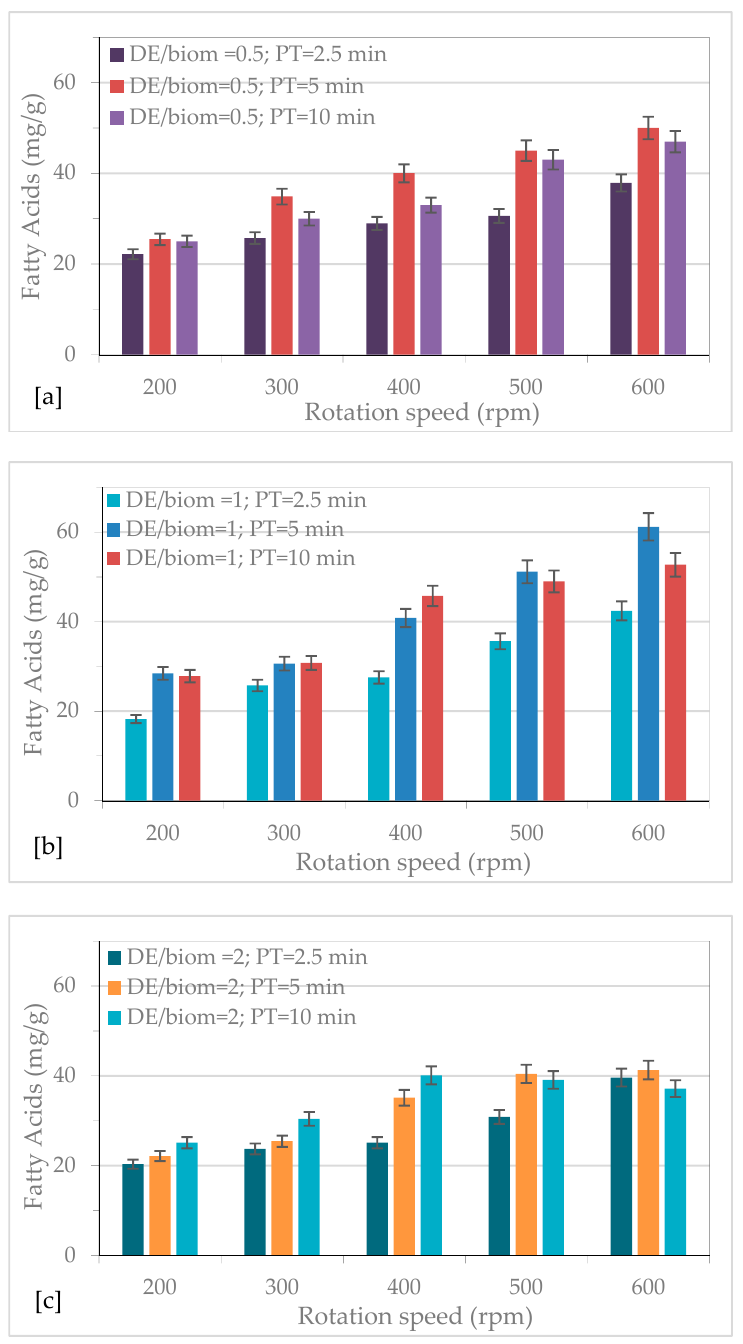
Figure 1. Effect of rotation speed and pre-treatment time on fatty acids (FAs) recovery with diatomaceous earth (DE)/biomass mixing ratio of: ( a ) 0.5; ( b ) 1; ( c ) 2.